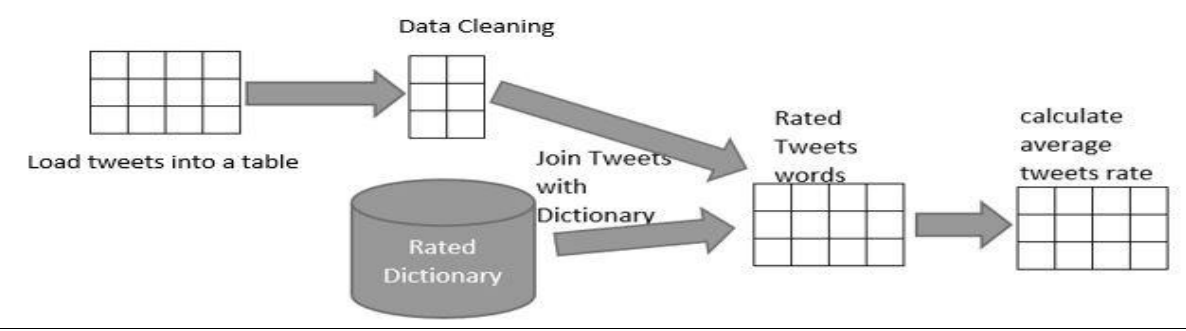
Figure 2. Data transformation and filtering in different